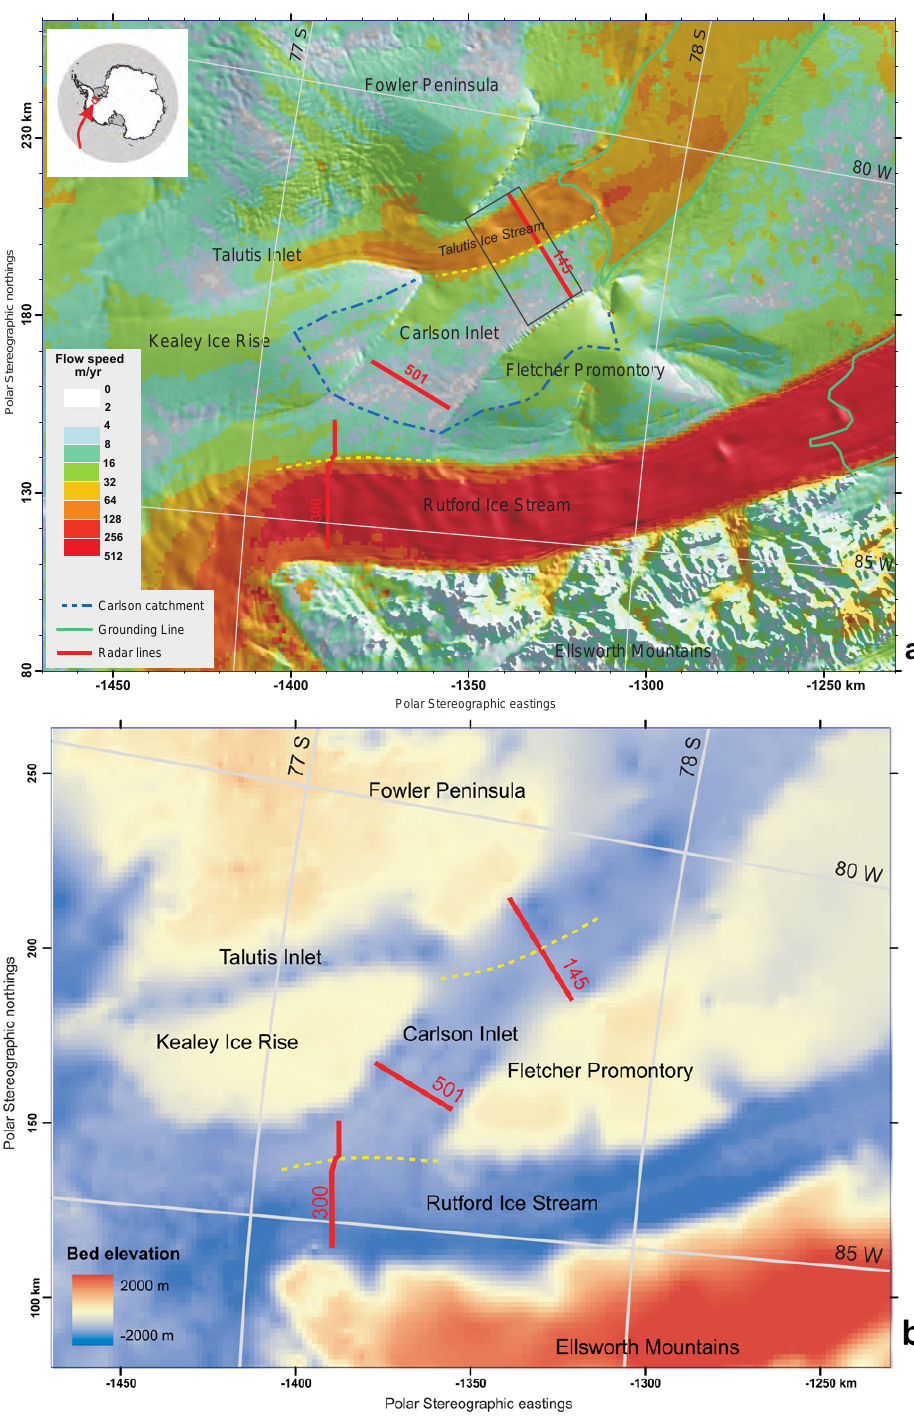
Fig. 1. Location map. (a) Background is a MODIS Mosaic of Antarctica (MOA) image (Haran et al., 2005: http://nsidc.org/data/moa), overprinted with flow velocities from inSAR analysis (Joughin and Bamber, 2005). Yellow dashed lines mark shear margins between fast flow in Rutford Ice Stream or Talutis Ice Stream (the fast-flow region originating in Talutis Inlet) and Carlson Inlet. Black rectangle marks outline of 3-D grid survey. Blue dash-dot line marks catchment boundary for Carlson Inlet. Polar Stereographic projection, grid is in metres from the origin. Geographic grid is in light grey. (b) Basal topography for the same area. Carlson Inlet and Rutford Ice Stream each occupy parallel-sided troughs about 30km